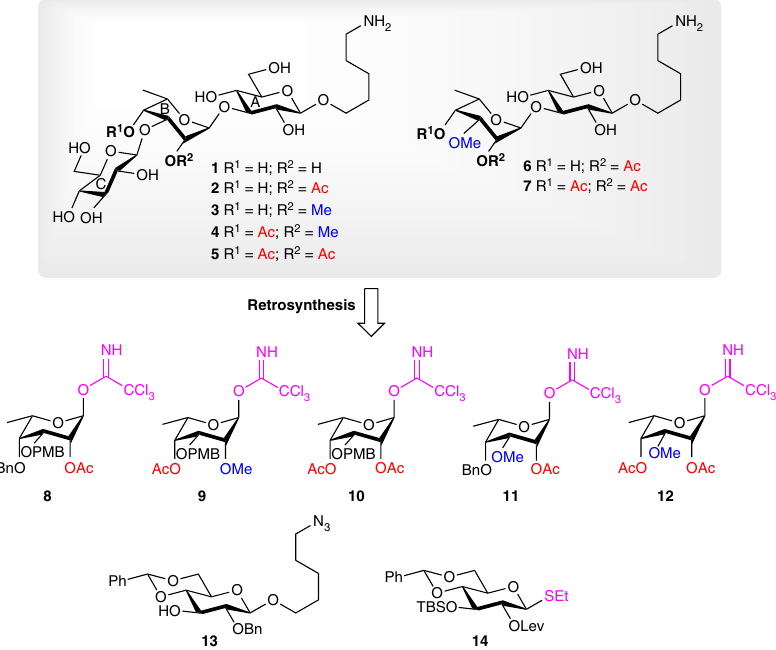
Fig. 2 Planned retrosynthetic analysis of the target oligosaccharides 1 – 7 . Ac acetyl, Bn benzyl, Lev levulinoyl, Ph phenyl, PMB para -methoxybenzyl, SEt thioethyl, TBS tert